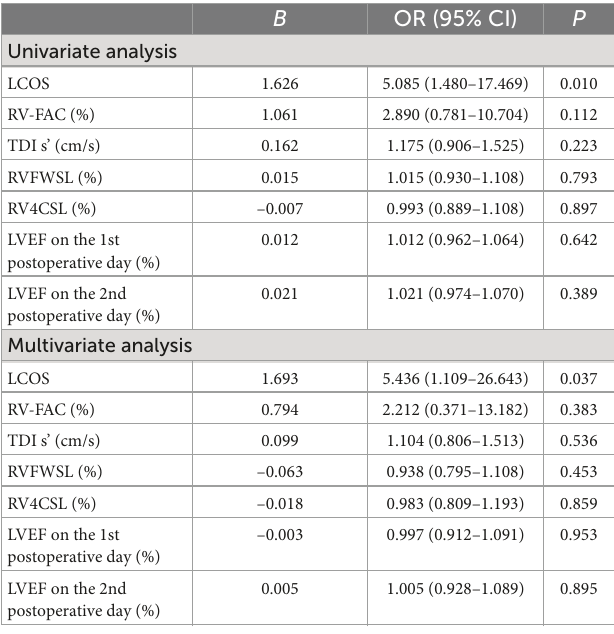
TABLE 3 Univariate and multivariate analysis to predict LCOS.